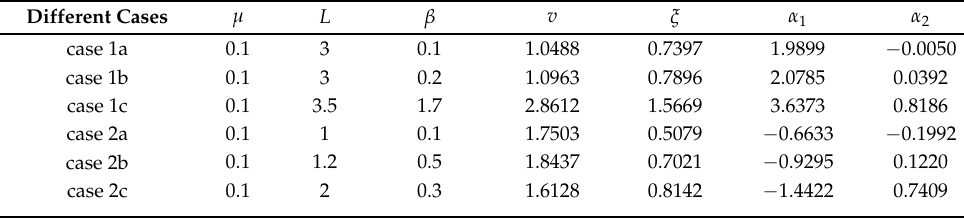
Table 2. The parameters of the system for different